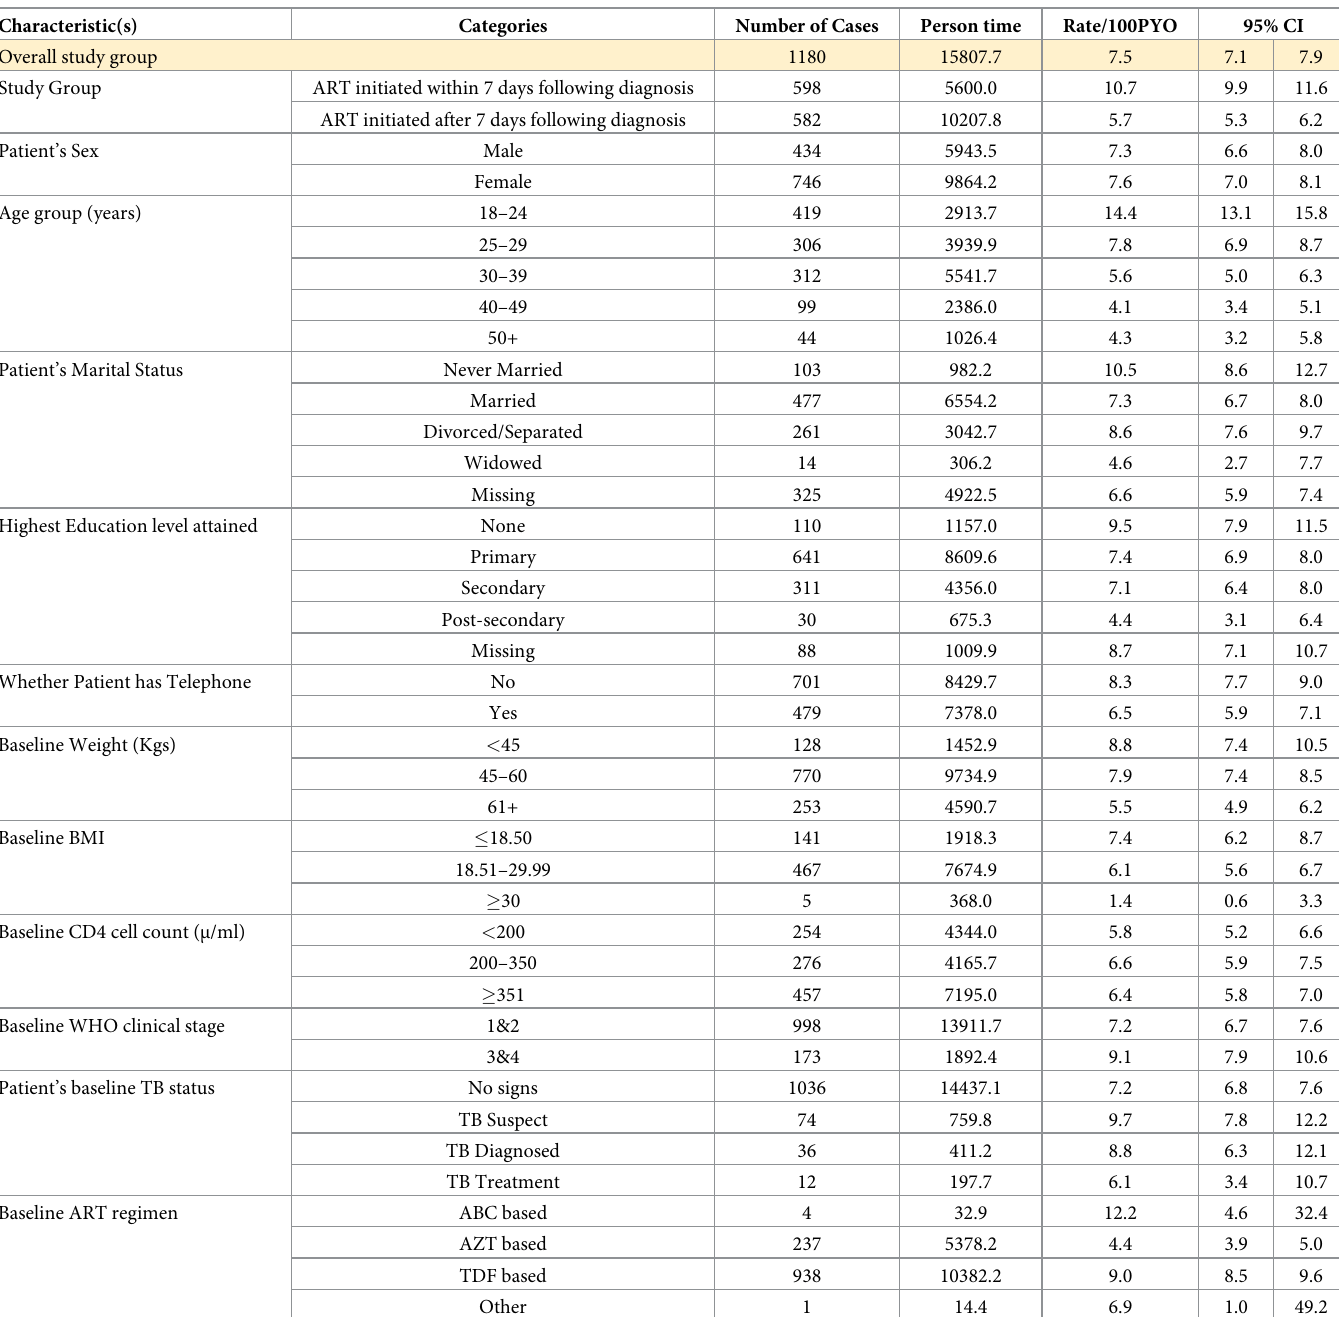
Table 2. Incidence rate of loss to follow up by patients